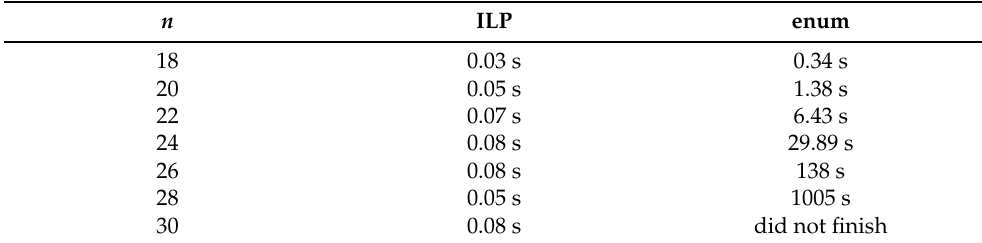
Table 2. Computational results for Pattern Equivalence—Diagonal